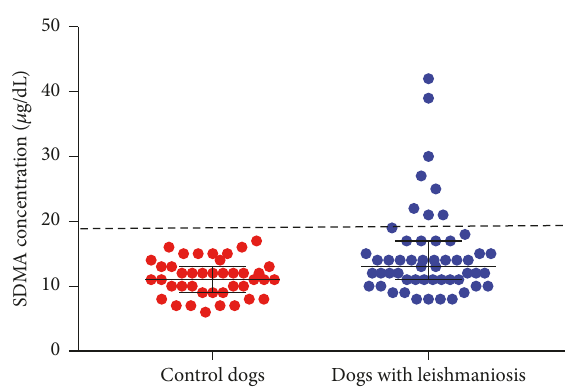
Figure 3: Distribution of SDMA concentrations in 53 dogs with leishmaniosis on the day of diagnosis classified according to LeishVet guidelines [16]. Stage I included 5 dogs, stage II 30 dogs, stage III 12 dogs, and stage IV 6 dogs. SDMA concentration was higher in dogs from stage IV with respect to stage I ( 𝑝 = 0.02 ), stage II ( 𝑝 = 0.006 ), and stage III ( 𝑝 = 0.004 ) dogs. The large black bar indicates the median of each group and the whiskers indicate the interquartile range. The dashed line indicates SDMA concentration of 19 𝜇